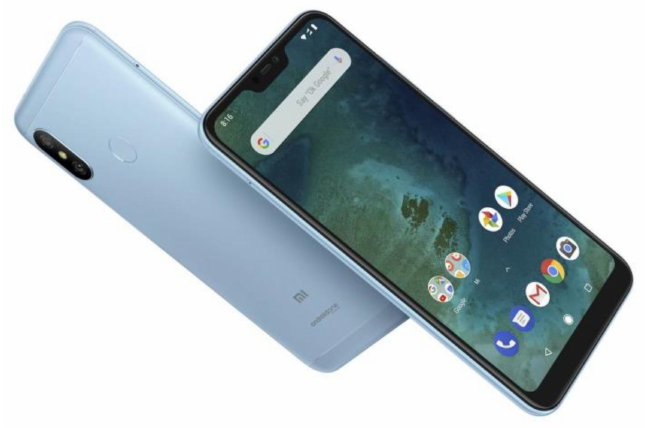
Figure 9. Smartphone Android Xiaomi A2 Lite.